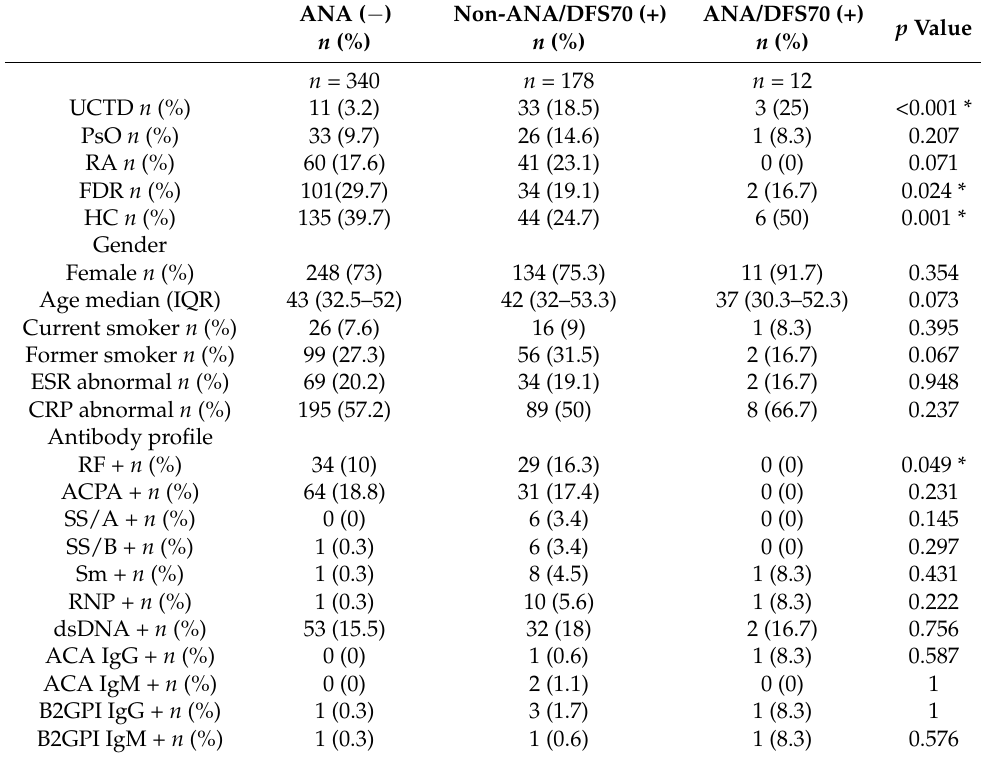
Table 1. Clinical and demographical variables for included